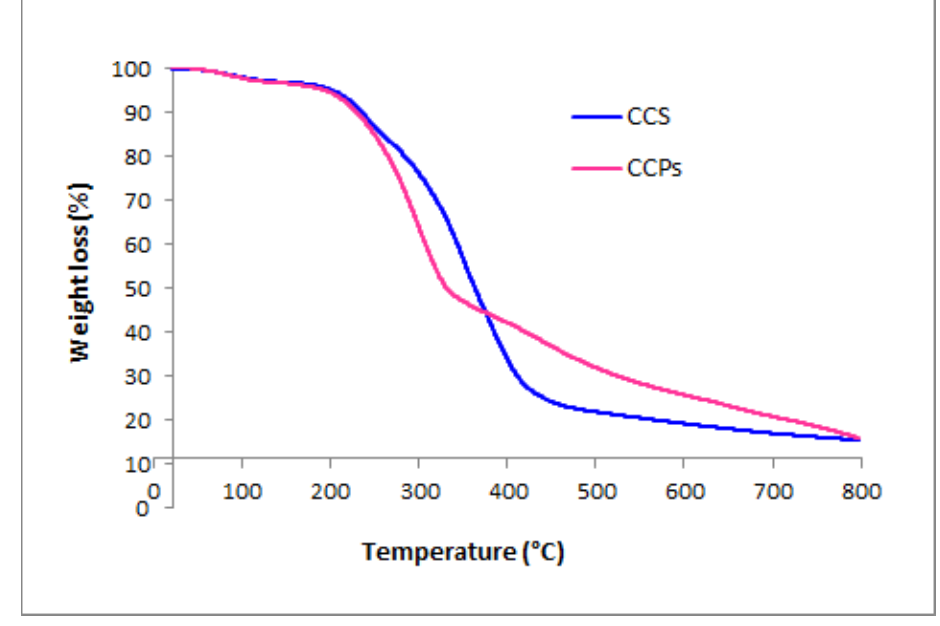
Figure 1. TG pyrolysis curves of CCSs and CCPs.